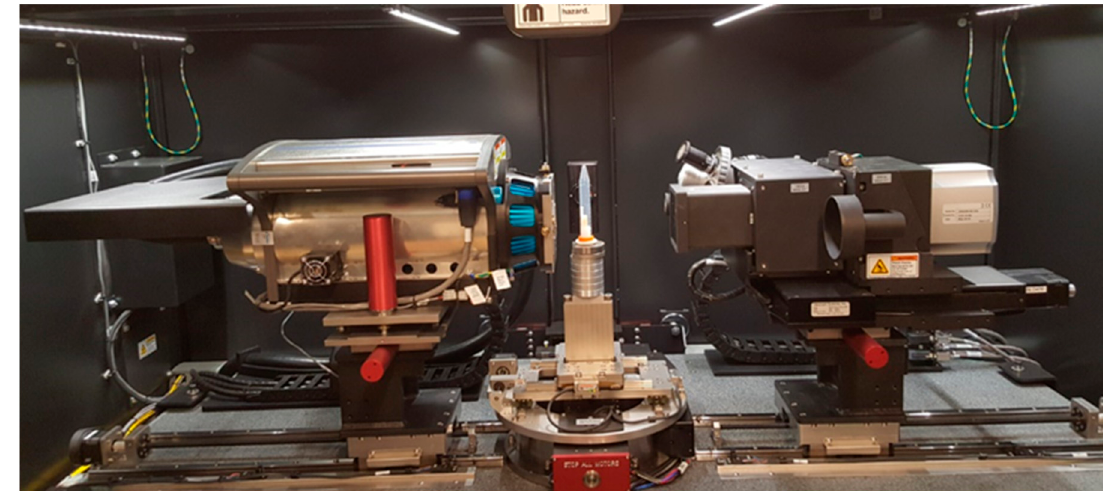
Figure 2. Setup in Micro-CT scanner.